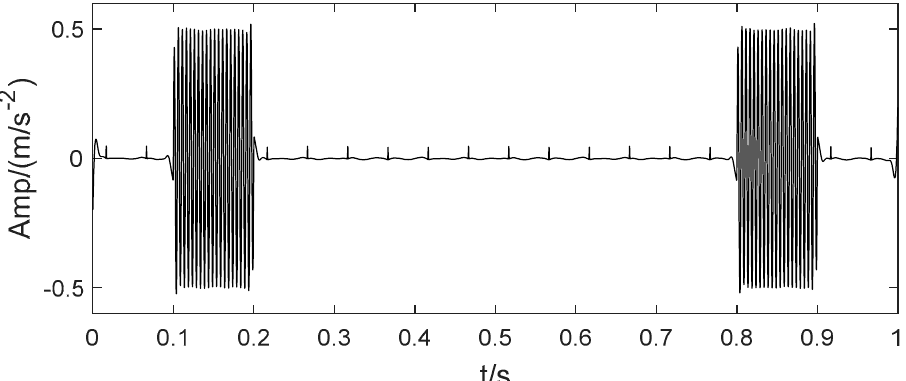
Figure 10. The second IMF component obtained by decomposition.